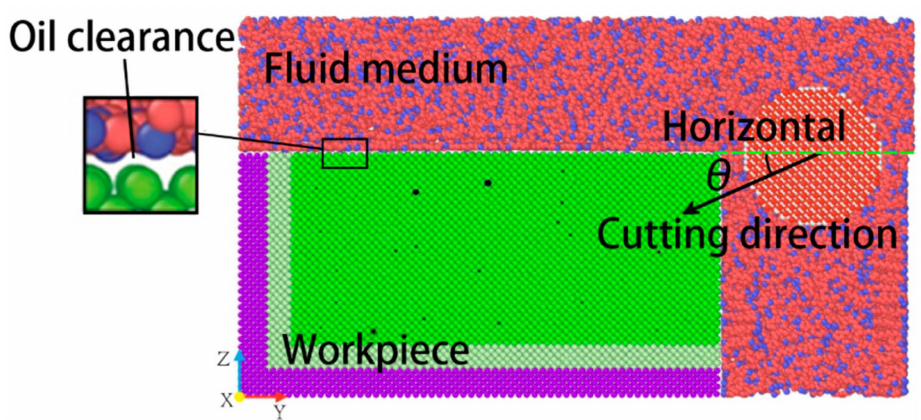
Figure 2. Longitudinal-sectional view of the system model after